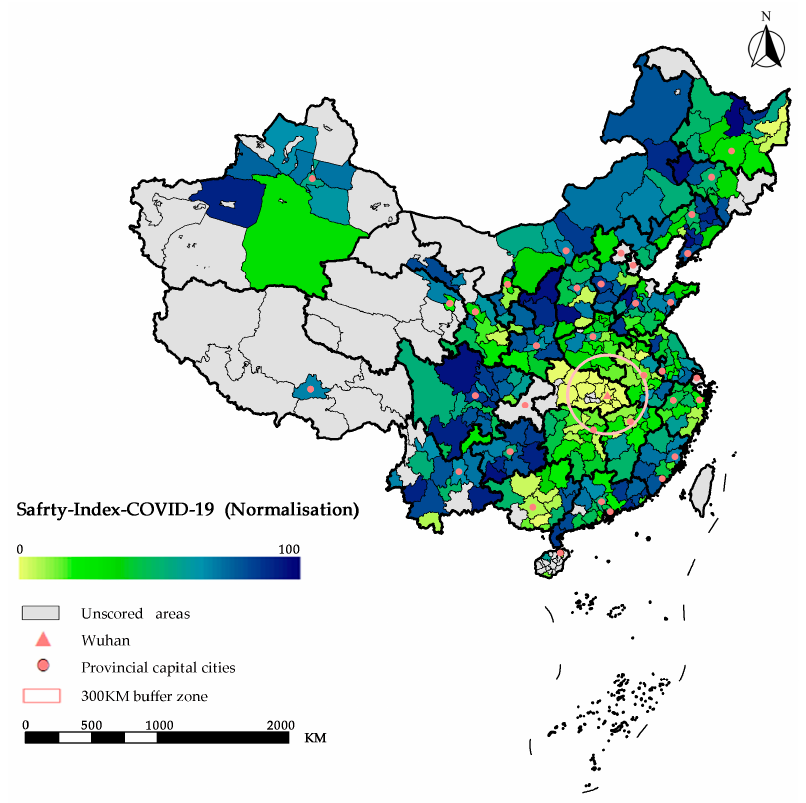
Figure 7. Distribution of the “COVID-19 safety index” scores in 333 cities in mainland China.